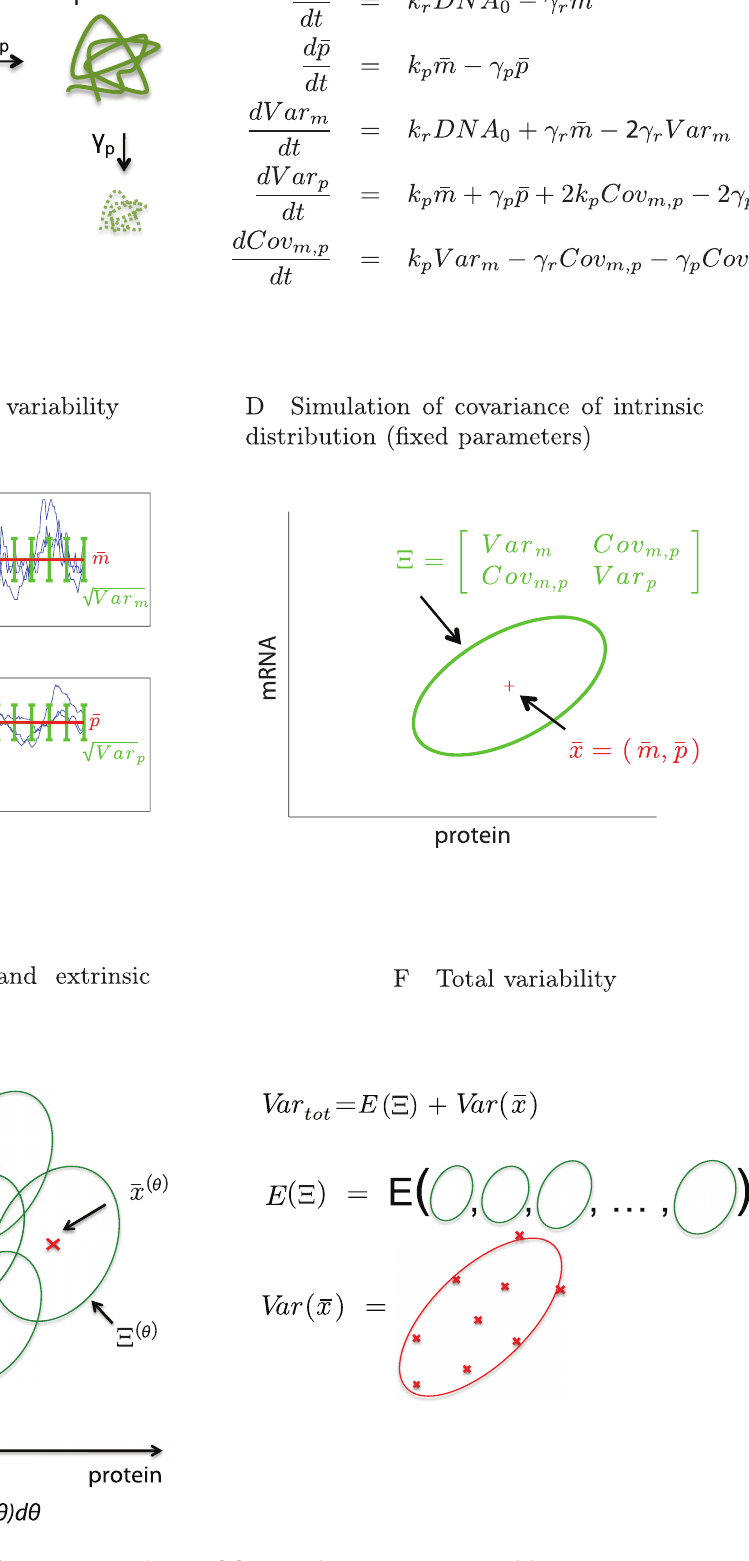
Figure 2. Framework illustrated on a single gene expression model. (A) Single gene expression model. (B) V -expansion equations (intrinsic stochasticity). (C) Simulation of intrinsic variability (fixed parameters). (D) Simulation of covariance of intrinsic distribution (fixed parameters). (E) Simulation of intrinsic and extrinsic variability. (F) Total variability. doi:10.1371/journal.pcbi.1002960.g002 PLOS Computational Biology | www.ploscompbiol.org 4 March 2013 | Volume 9 | Issue 3 |